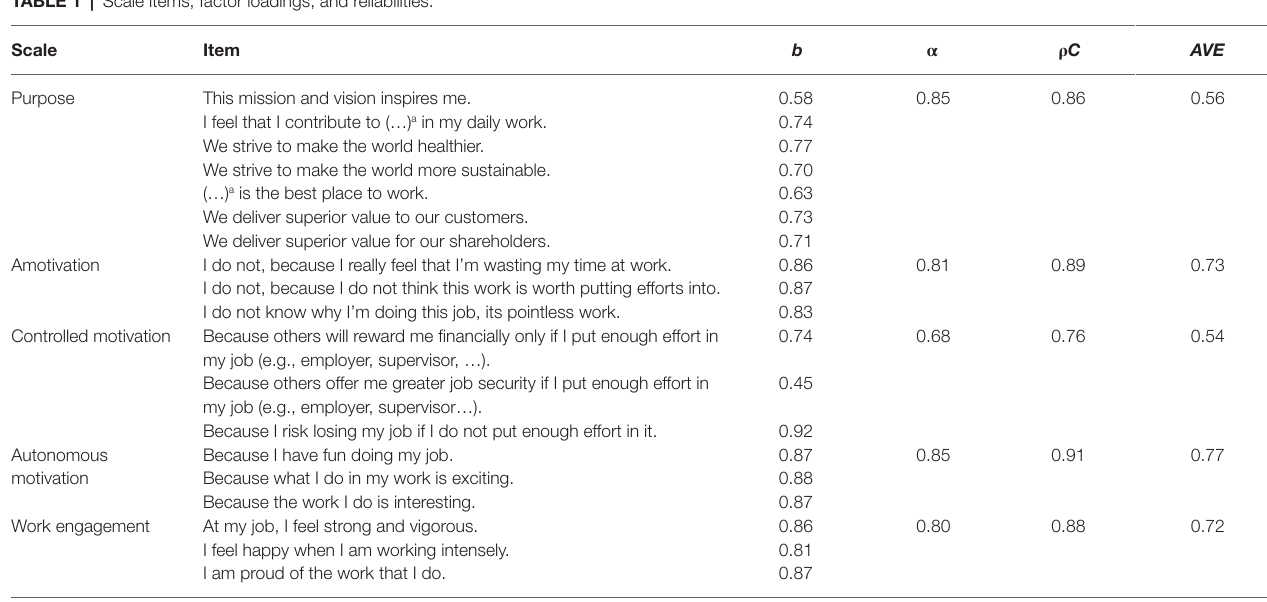
TABLE 1 | Scale items, factor loadings, and